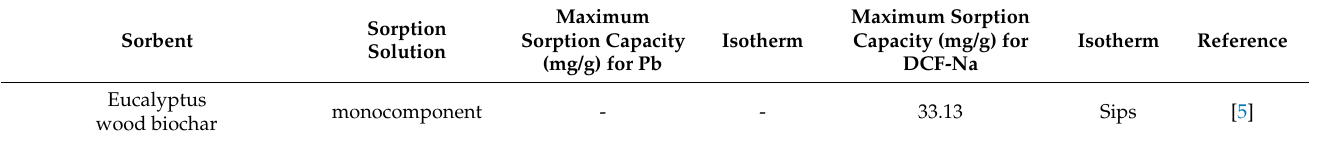
Table 5. Literature comparison of sorbents for Pb 2+ ions and DCF-Na